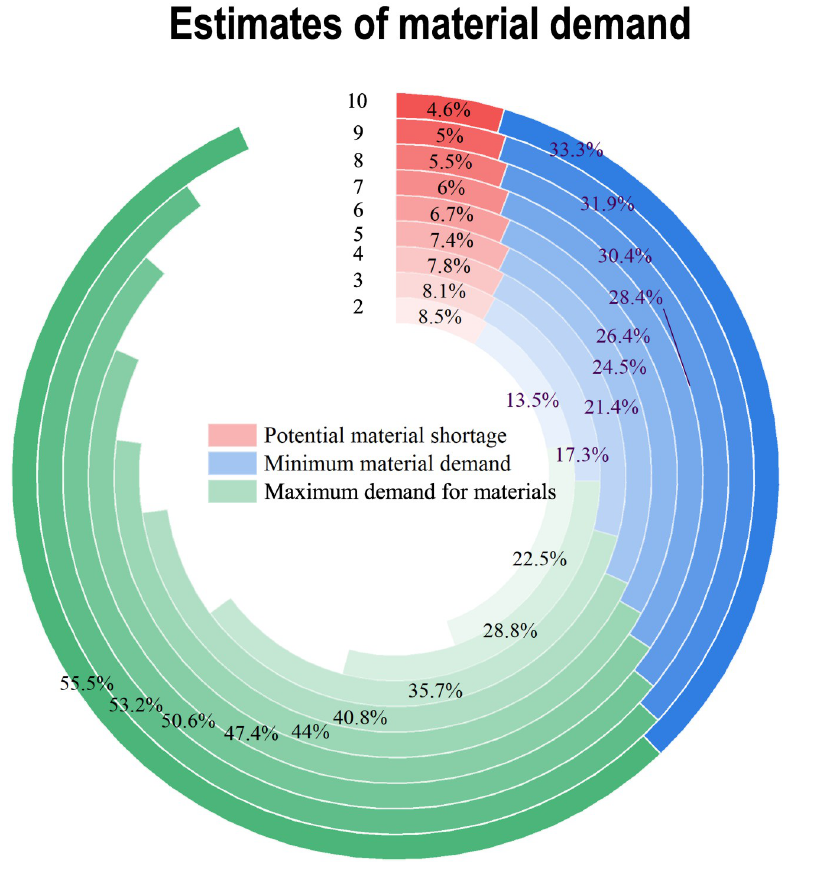
Fig 5. Material demand